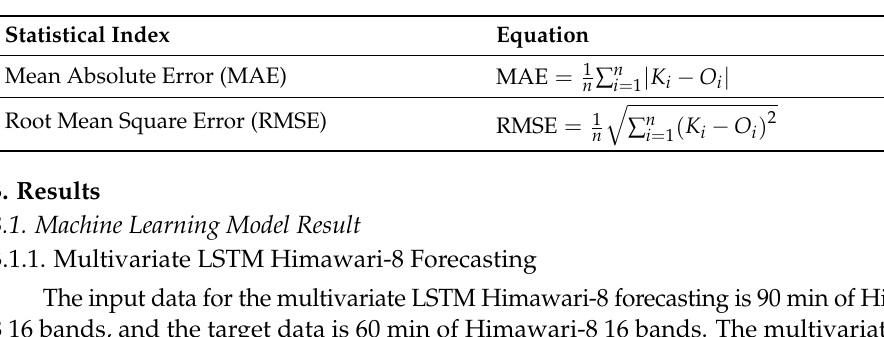
Table 2. Statistical indices used to evaluate the performance of rainfall forecasting results. K is the simulated data, O is the observed precipitation data, and n is the number of